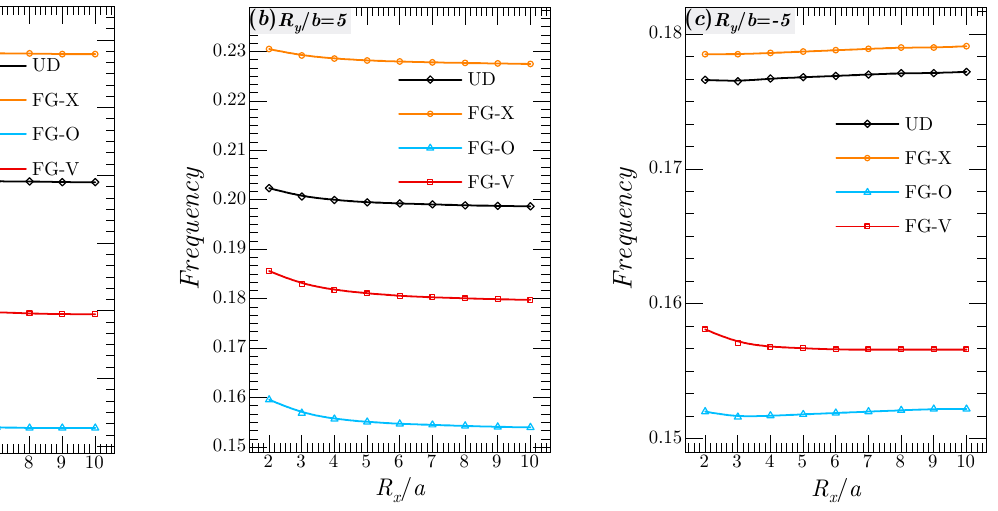
Figure 8. Effect of temperature on the dimensionless frequency of various shell types (𝑇𝑦𝑝𝑒(𝐵), 𝑆𝑆𝑆𝑆, 𝑁 = 10 𝑉 (cid:3030)(cid:3041)(cid:3047)∗ = 0.17, 𝑝 = 1 ). The impact of various boundary conditions and the geometry of the CNTRC(B) plate ( b / a and a / h ) on the frequencies is plotted in Figure 9. The dimensionless frequencies decrease with decrease in the thickness ratio a / h . For the aspect ratio b / a effect, the frequencies decrease critically for values 𝑏/𝑎 ≤ 2 . In addition, the fully clamped shells have the highest values of frequency, while the lowest values are for the simply supported one.